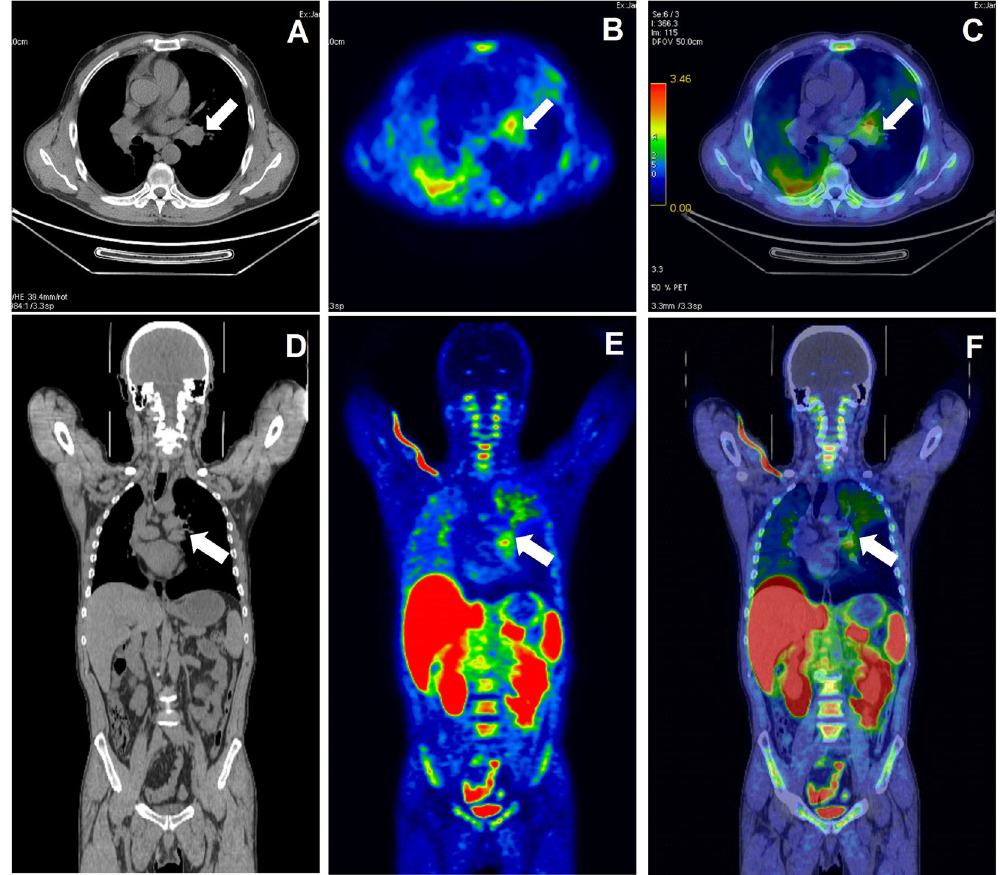
Figure 6. 18F-IRS PET/CT scan in a patient with NSCLC of left lung. (white arrow indicates tumor area) ( A ) Transaxial CT image. ( B ) Transaxial PET image. ( C ) Transaxial PET/ CT image. ( D ) Coronal CT image. ( E ) Coronal PET image. ( F ) Coronal PET/CT image.